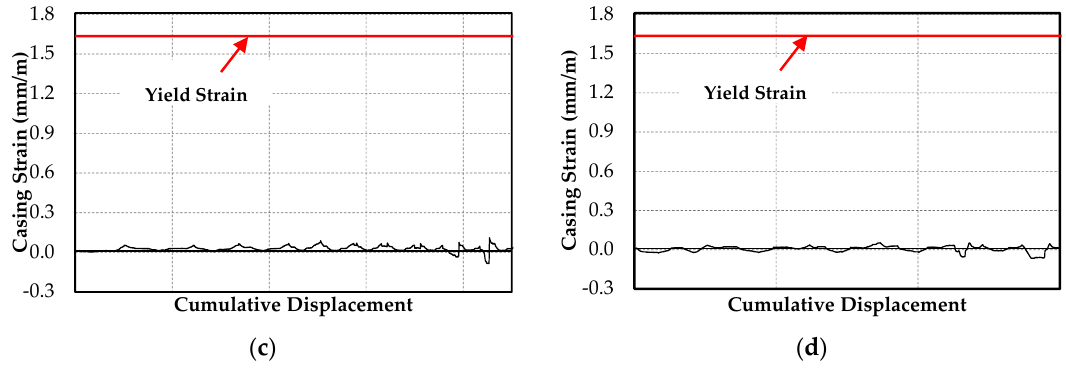
Figure 8. Longitudinal casing strain. Specimens ( a ) 1, ( b ) 2, ( c ) 3, and ( d ) 4.